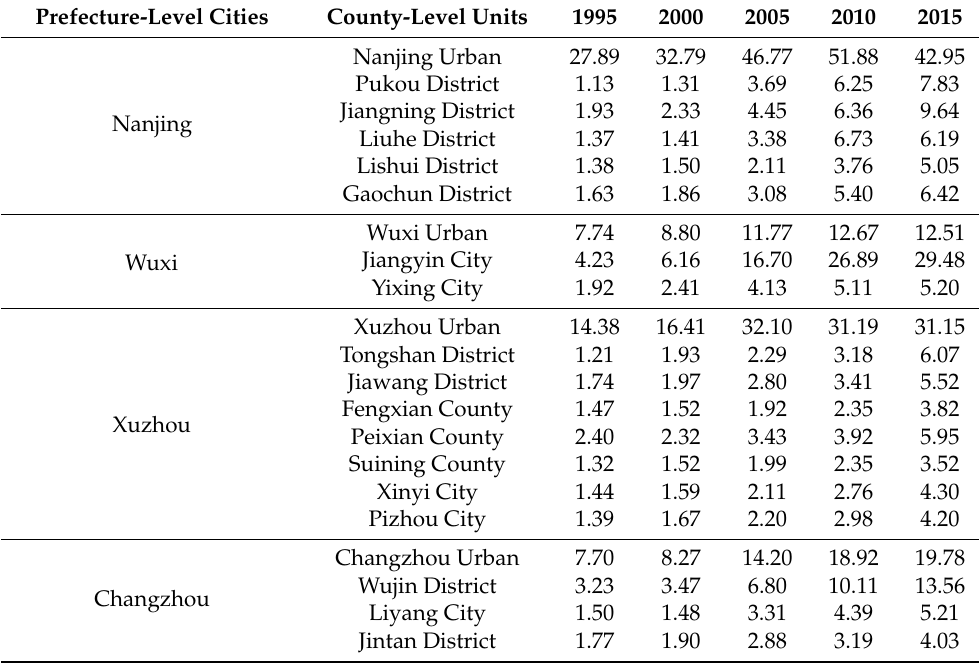
Table A2. EFDs of counties of Jiangsu in